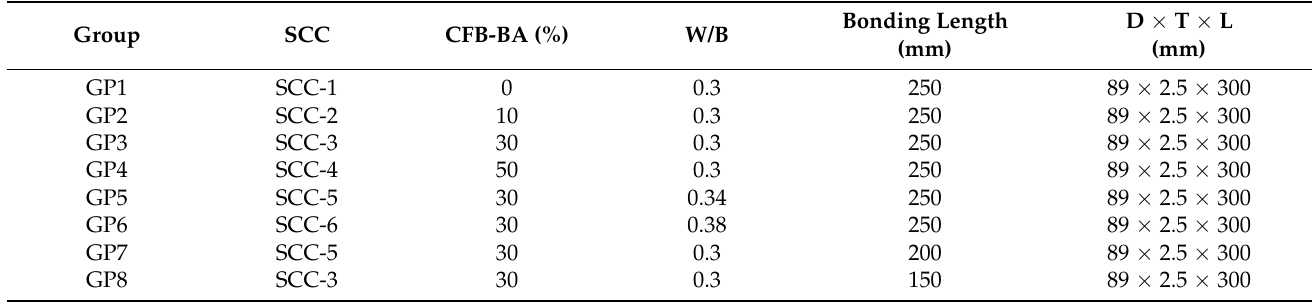
Table 6. Component parameters of CFSTs.